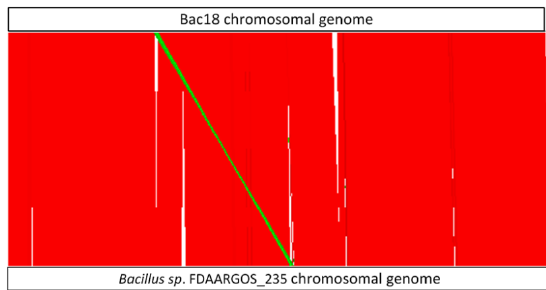
Figure 3. Visualization of the structural similarities of Bac18 and Bacillus sp. FDAARGOS_235 chromosomal genomes calculated with Nucmer. Genomes are given as white boxes at the top (Bac18) and the bottom ( Bacillus sp.) of the illustration. For comparison, both circular genomes are opened at the starting position of the dnaA gene. Red: homologous sequences with the same orientation; green: reverse complement, but homologous sequences, white: regions without homologies.